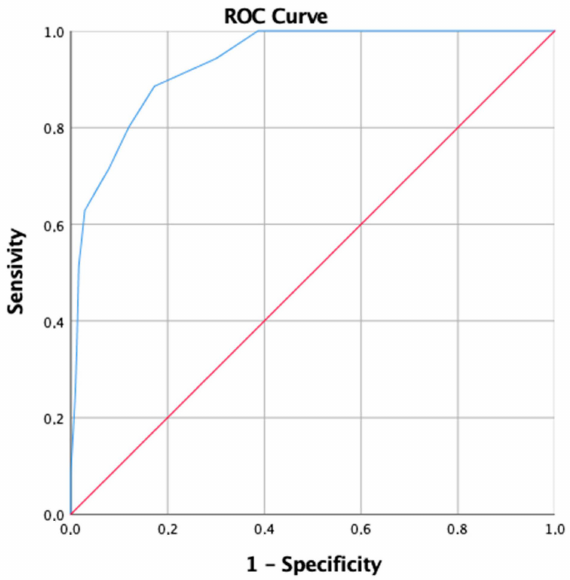
Figure 1. Graphical representation of receiver operator characteristic curve of the PSQI global